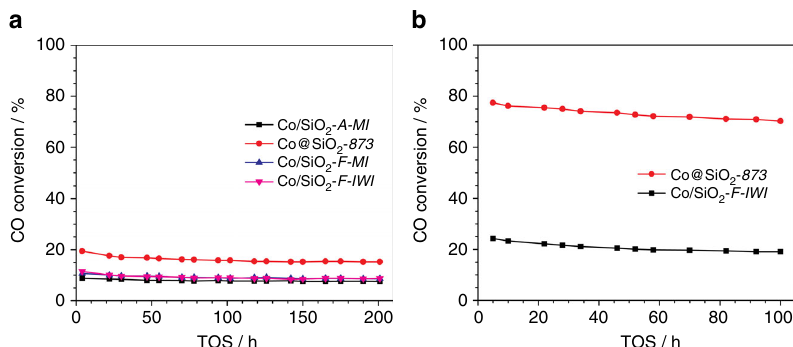
Fig. 5 Catalytic performance. a Time-on-stream evolution of CO conversion for the Co@SiO 2 - 873 and Co/SiO 2 catalysts prepared using conventional methods. M ’ refers to melt in fi ltration. IWI refers to incipient wetness impregnation. A refers to Aerosil-200 support and F refers to CARiACT Q-10 support. Reaction conditions: 483 K, 20 bar, H 2 /CO = 1, and syngas fl ow of 40 ml min − 1 . b Time-on-stream evolution of CO conversion for the Co@SiO 2 - 873 and Co/SiO -F-TIWI catalysts prepared using two-step incipient wetness impregnation method ( TIWI ). Reaction conditions: 483 K, 26 bar, H 2 and syngas fl ow of 40 ml min − 1